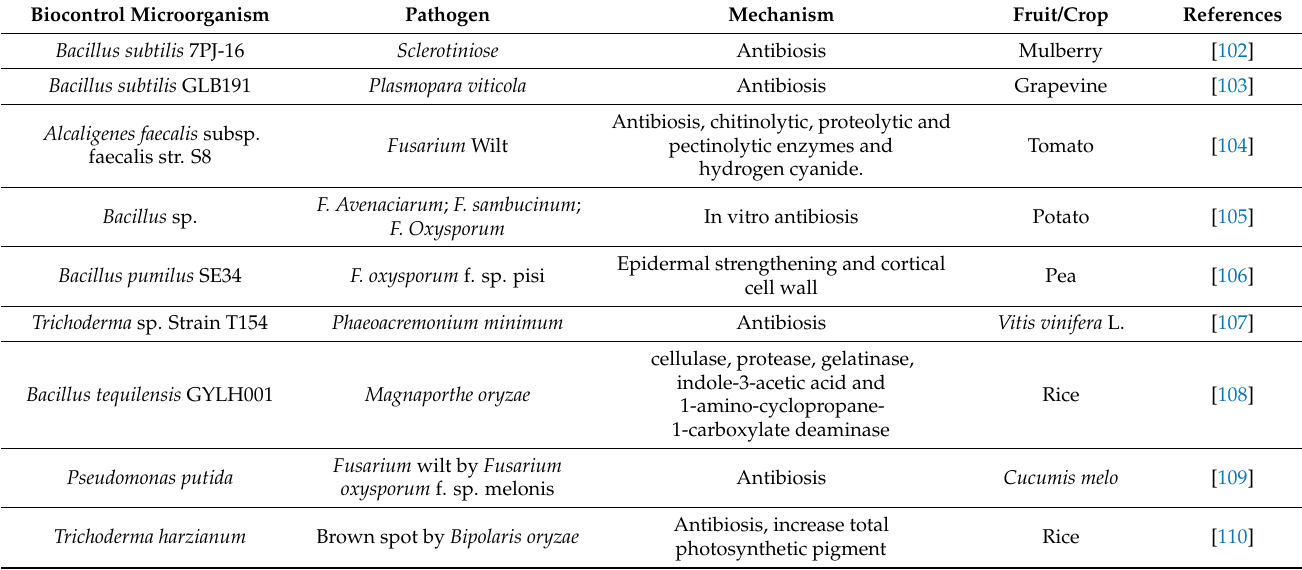
Table 1. Biocontrol agents and their mechanism of action against pathogenic microorganism and their associated